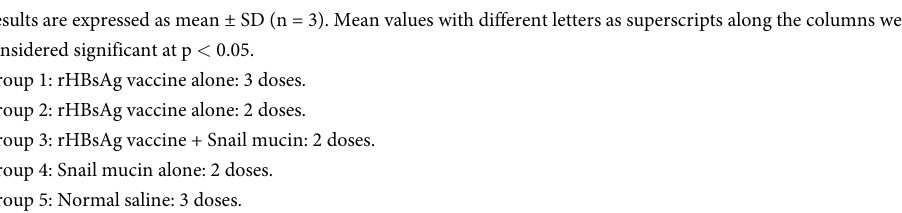
Table 1. Effect of snail mucin-adjuvanted rHBsAg vaccine on liver marker enzyme activities of experimental mice. Group AST (U/L) ALT (U/L) Group 1 147.99 ± 16.09 a 47.62 ± 5.18 a Group 2 157.01 ± 13.49 a 41.71 ± 3.54 a Group 3 160.92 ± 18.80 a 42.20 ± 4.92 a Group 4 135.01 ± 12.05 a 45.58 ± 2.94 a Group 5 140.51 ± 15.21 a 40.35 ± 2.27 a Results are expressed as mean ± SD (n = 3). Mean values with different letters as superscripts along the columns were considered significant at p <